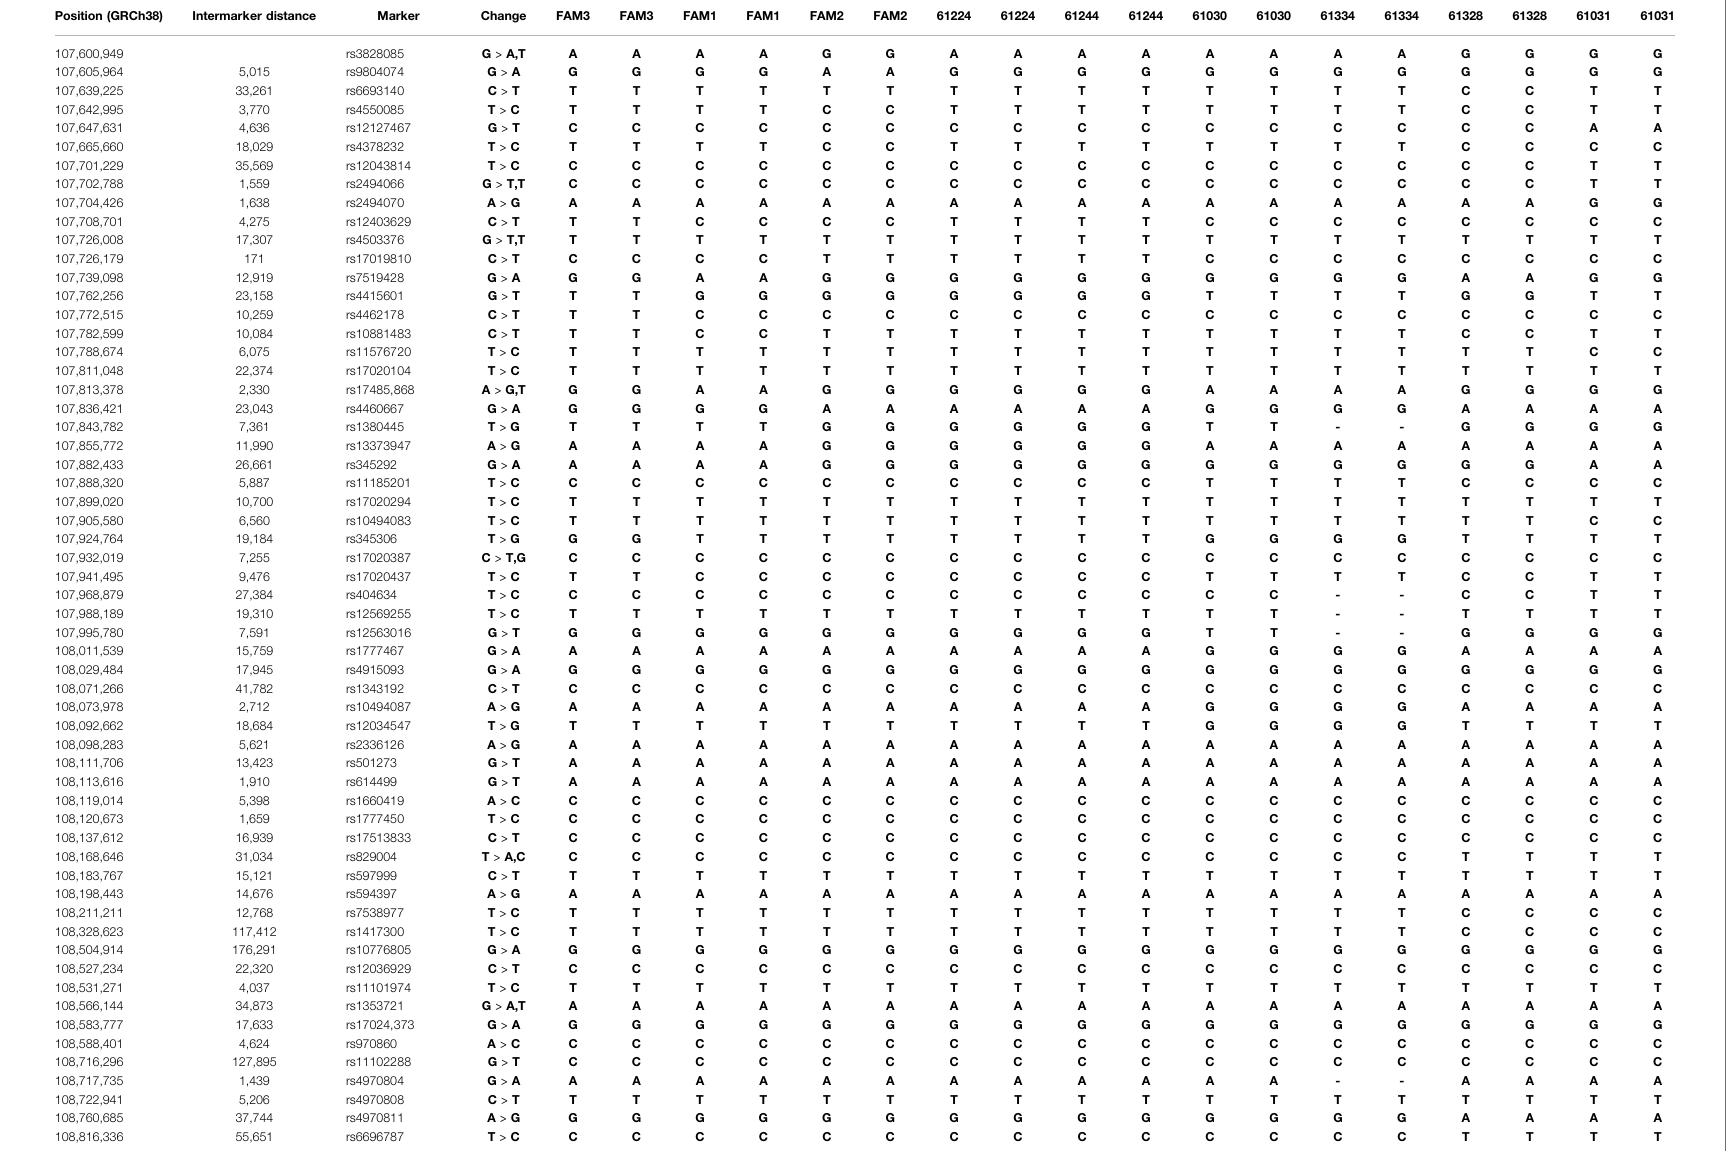
TABLE1| Summaryofthehaplotypesforeachfamily.InTable1inthe SupplementaryMaterial theoriginalriskhaplotypeisshowninblueandrecombinedhaplotypesheldincommonbypairsoffamiliesshowingidentical recombination points are highlighted various shades of green. The haplotype blocks composed ofSNPs showing no recombination inaffected members ofthe nine families are shown in alternating orange and yellow in the marker column (GRCh38.p13). The genomic position of the CLCC1 mutation is shown in bold